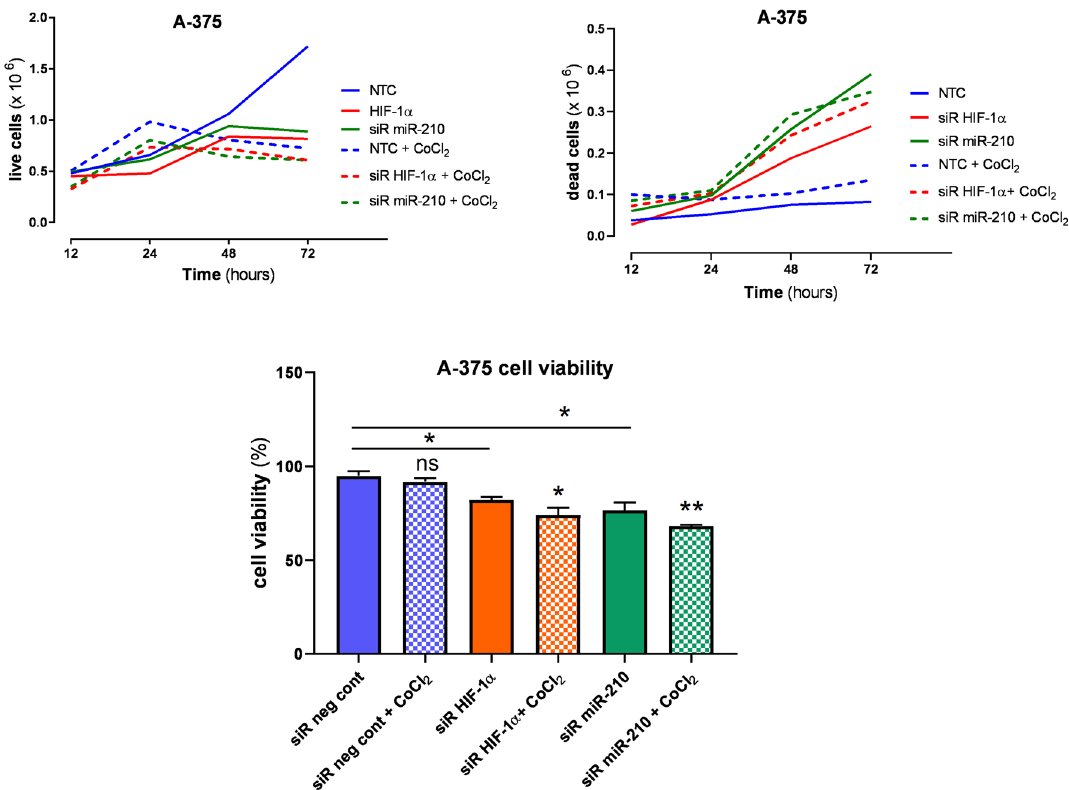
Figure 7. Cell growth line of each analyzed group per live and dead cells (12–72 h); cell viability (48